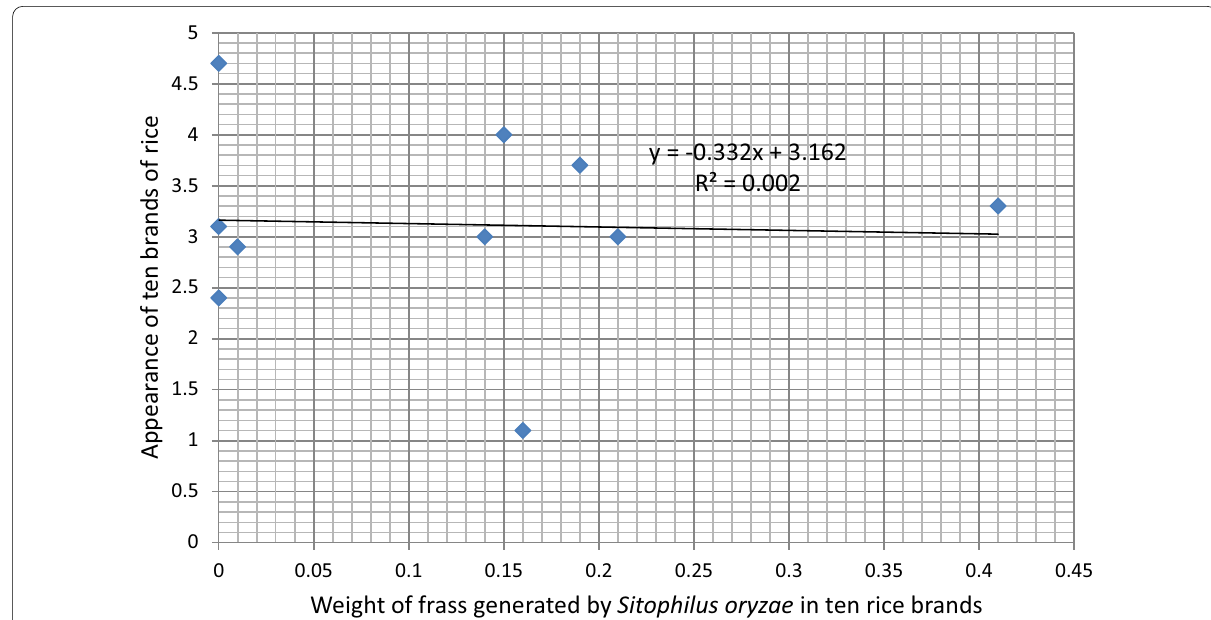
Fig. 6 Association between rice brand appearance and weight of frass generated by Sitophilus